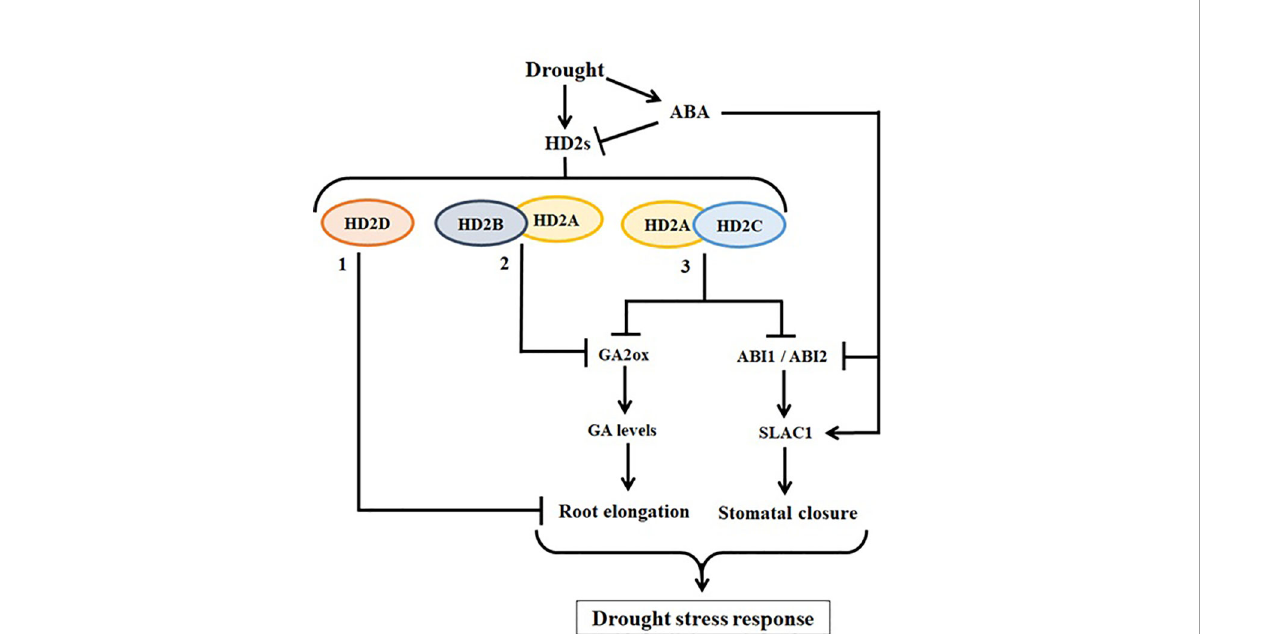
FIGURE 10 The working model of HD2 family HDACs involved in drought stress response in Arabidopsis. (1: Han et al., 2016) HD2D was reported previously as a negative regulator of primary root length. Overexpression of HD2D caused a decrease in primary root length and increase in the number of secondary roots, and HD2D-OE plants showed enhanced tolerance to drought stress. (2: Li et al., 2017) HD2A and HD2B were shown to negatively coregulate the expression of GA2ox2 via histone acetylation modi fi cation, leading to decreased primary root growth in hd2a . hd2b double mutant. GA2ox genes are involved in the catabolism of bioactive gibberellins. (3) Our study showed that HD2A and HD2C coordinate to play role at both leaf and root levels by modulating the expression of ABI1 and ABI2 , involved in ABA-mediated stomatal closure, and GA2ox genes. The knockout of both HD2A and HD2C showed abnormal stomatal functioning and decreased root growth in hd2a . hd2c double mutant, leading to decreased drought stress response. All arrow heads represent positive regulation, while all stop lines represent negative regulation associated with related